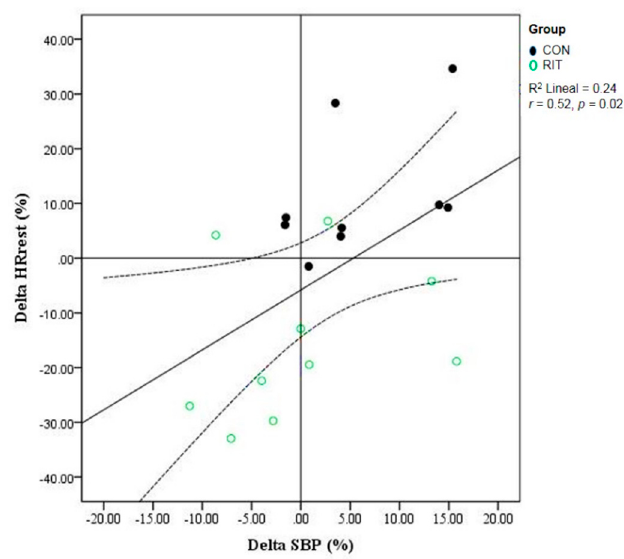
Figure 3. Scatter plot for the correlation analysis between ∆ HRrest and ∆ SBP. ∆ = ([Post-intervention– Pre-intervention values] / Pre-intervention values]) × 100. Dashed lines are the 95% CI around the regression line. r = 0.52, p = 0.02.